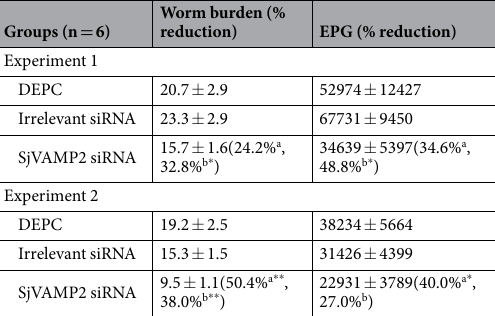
Worm burden (% reduction)